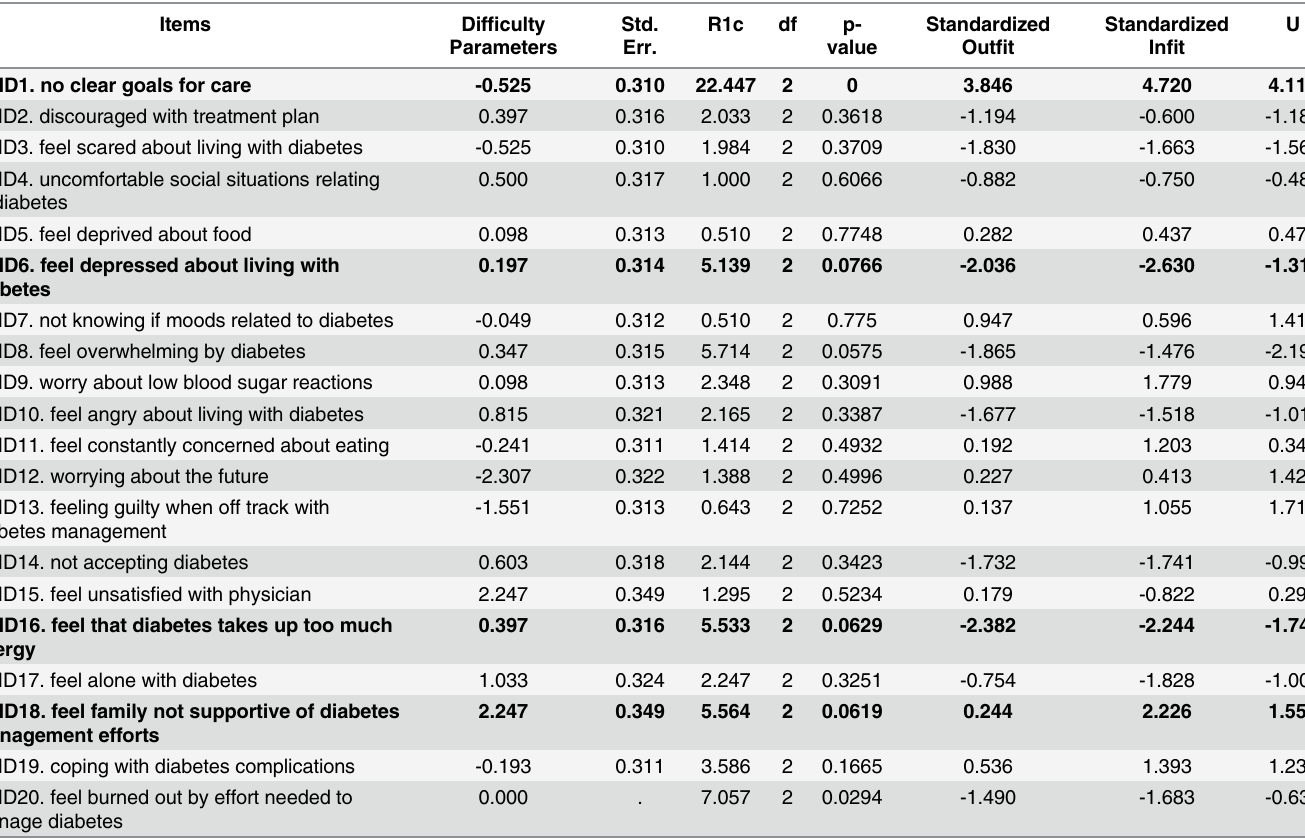
Table 2. Item difficulty and fit statistics from Rasch